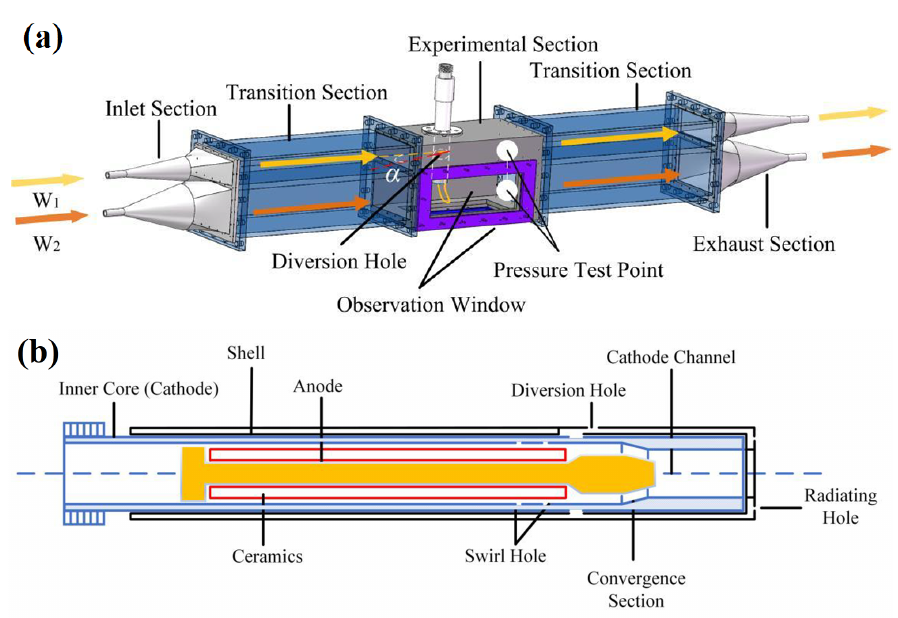
Figure 2. ( a ) The twin-duct ignition platform and ( b ) the schematic diagram of the gliding arc igniter